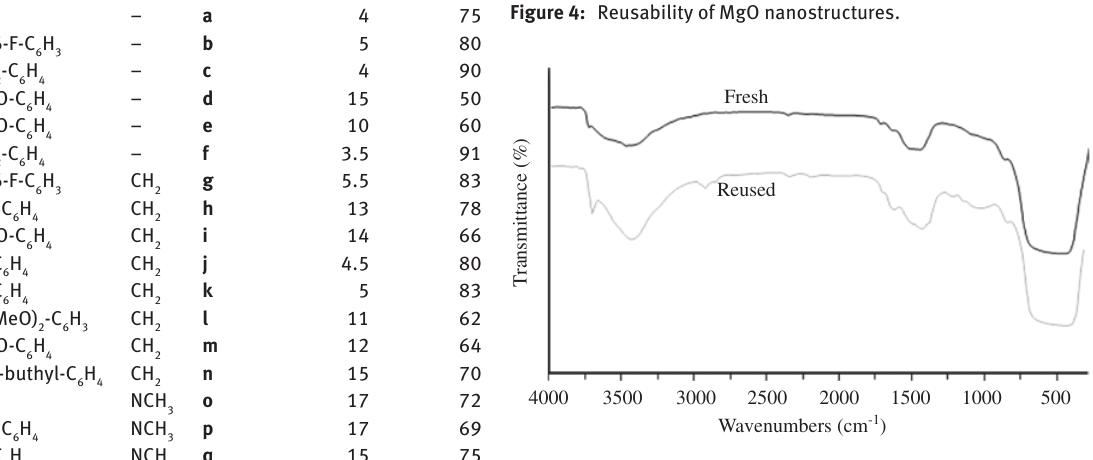
Figure 4: Reusability of MgO nanostructures.